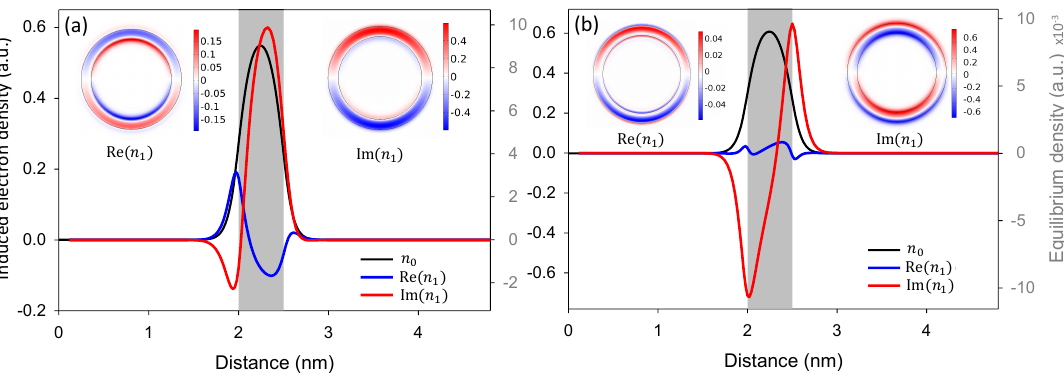
Figure 8. Induced electron density for Au nanoshell at ( a ) LEM and ( b ) HEM. The insets show the map plots for real and imaginary part of the induced